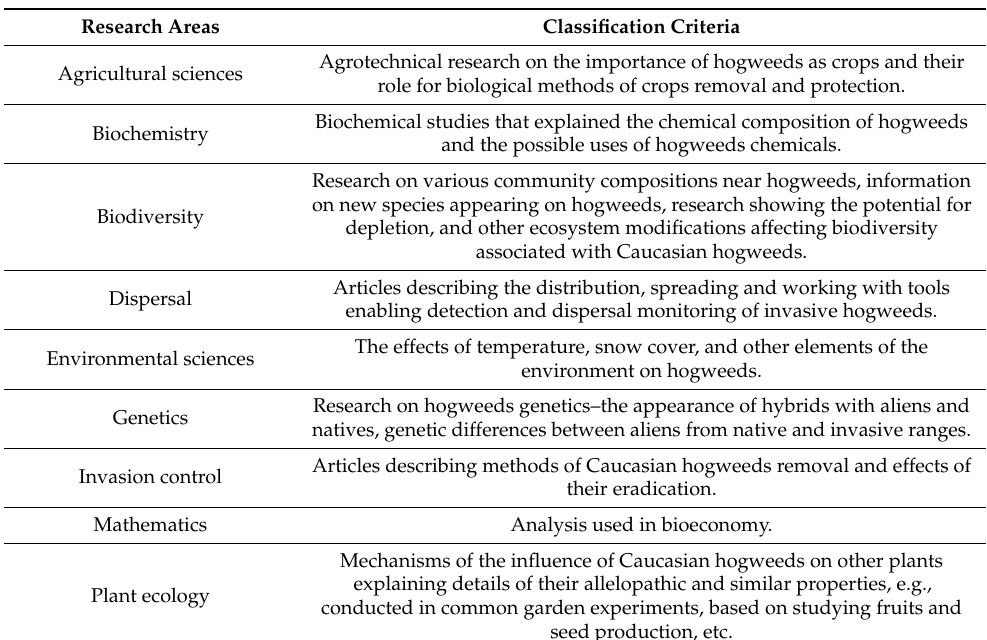
Figure 1. PRISMA flow diagram with the search of articles for this study showing numbers excluded at the particular stages of this review. Only articles retrieved from the “Scopus” (Elsevier) database were presented. Table 1. List of the research areas used for sorting the articles concerning the giant hogweed and the Sosnowsky’s hogweed found in the “Scopus” database.